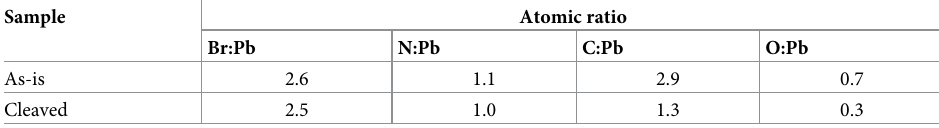
Table 1. Summary of atomic ratio determined from XPS relative atomic quantification.